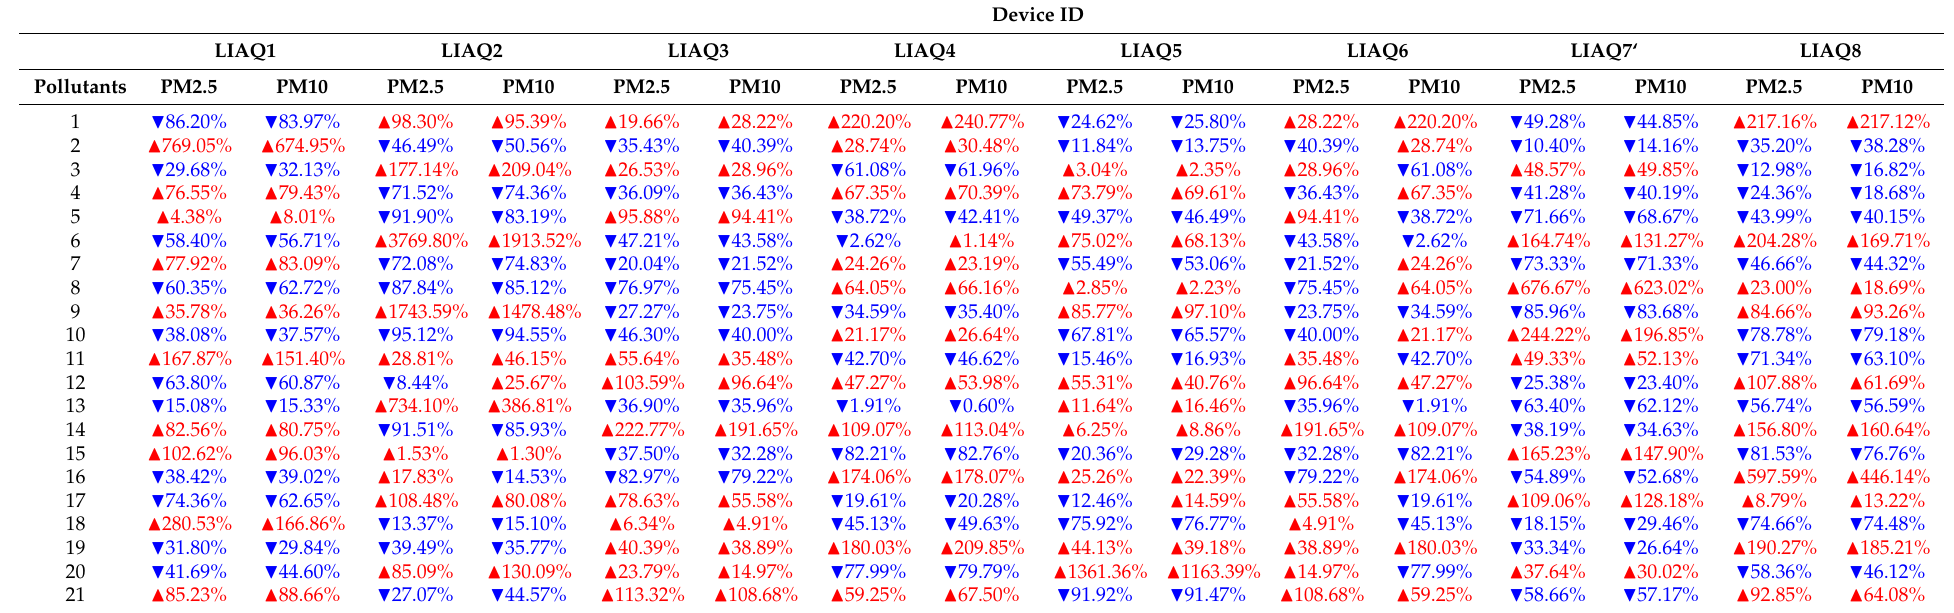
Table 9. Daily percentage change in PM 2.5 and PM 10 readings from all